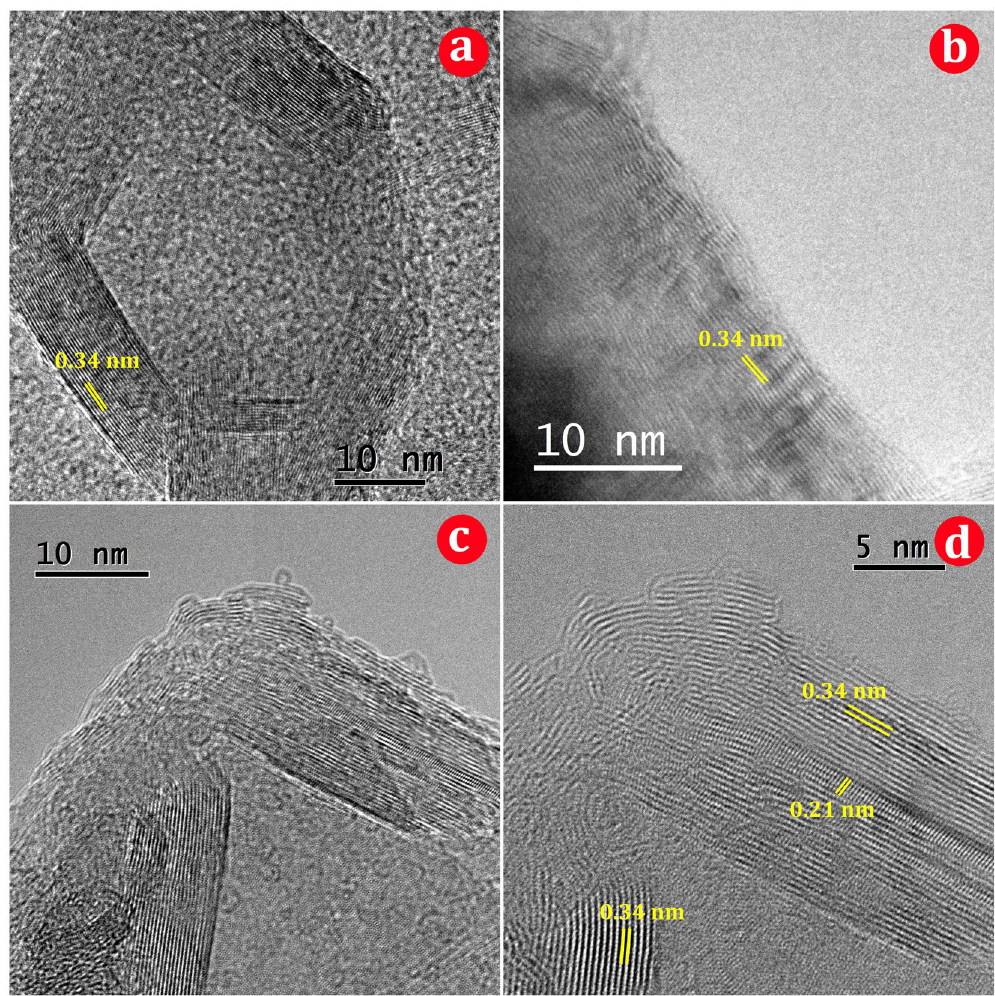
Figure 8. HRTEM images of the BCN nanosheets: ( a ) one hexagonal closed hollow shell, ( b ), ( c ), and ( d ) different positions in the edges of the nanosheets.